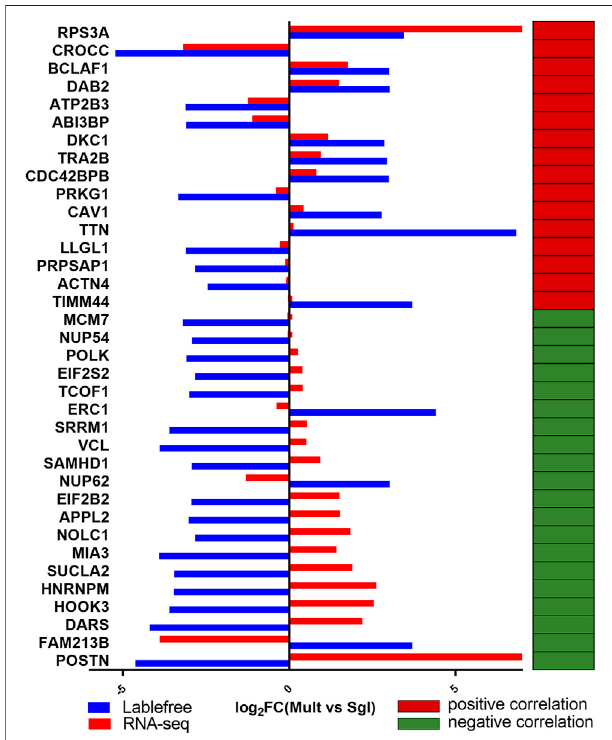
FIGURE4 | Analysis onthe expression trendconsistencyof differentially expressedproteingenes.Mult,SmallTailHansheepgroup;Sgl,Xinji fi newool sheep group. The blue and red column diagrams represent the expression of proteinandmRNA,respectively.Theredandgreencellsshowapositive and negative correlation, respectively, between the expression trend of the corresponding mRNA and